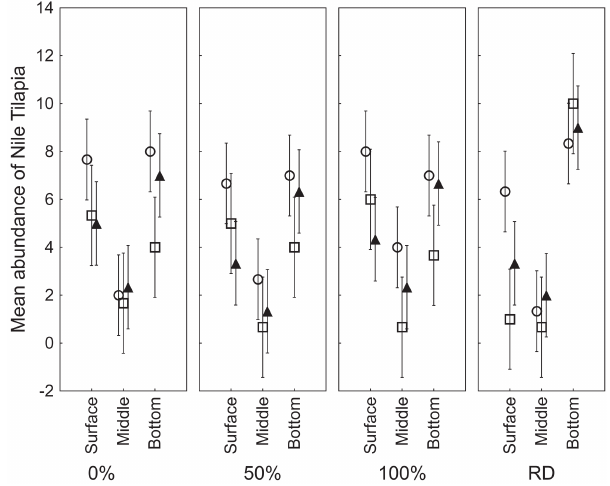
Fig. 5 . Use of microhabitat (surface, middle and bottom layers) by the native predators (mean ± SD) Pseudoplatystoma corruscans (white circles), Salminus brasiliensis (white squares) and Brycon orbignyanus (black triangles), for 0%, 50%, 100% and RD treatments. The three-way ANOVA for these data showed significant interaction (P = 0.049) among species, structural habitat complexity and microhabitat. All species of native predators used the bottom layer of the tank more frequently.